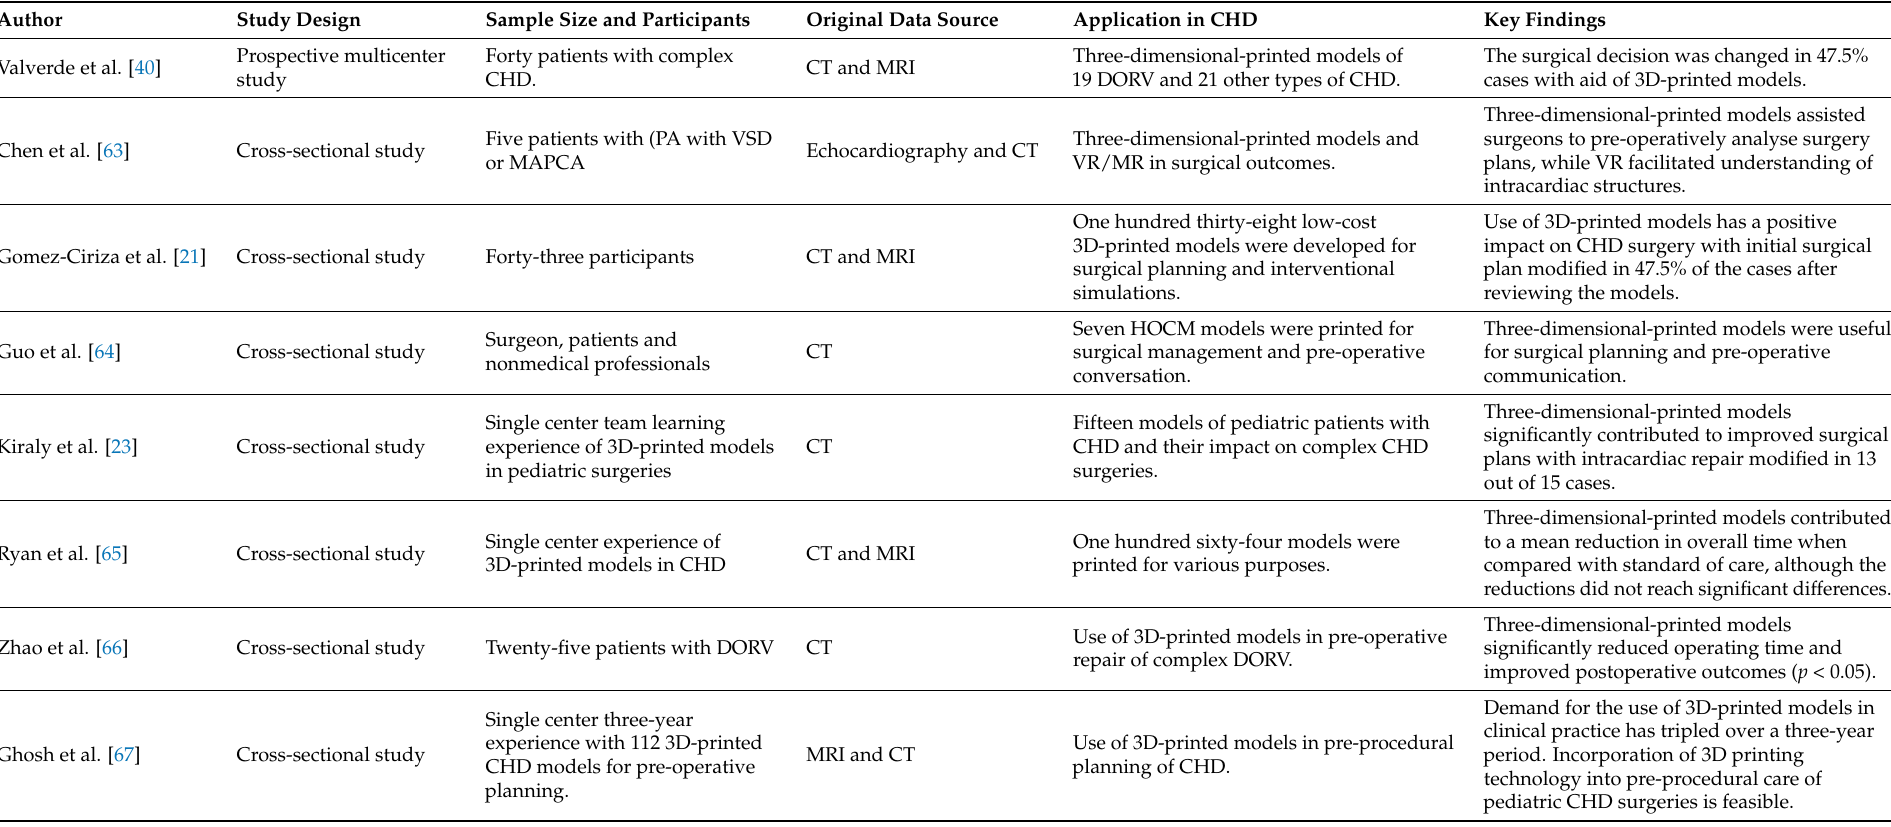
Table 3. Clinical value of 3D-printed CHD models in the surgical planning of CHD surgery. Modified from Sun and Wee